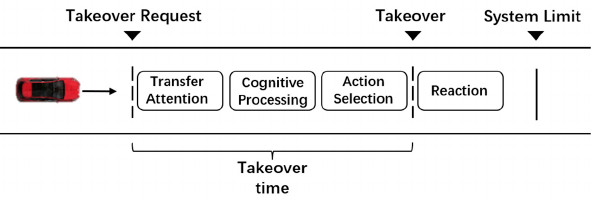
Figure 1. Processes underlying the driver takeover during conditionally automated driving.